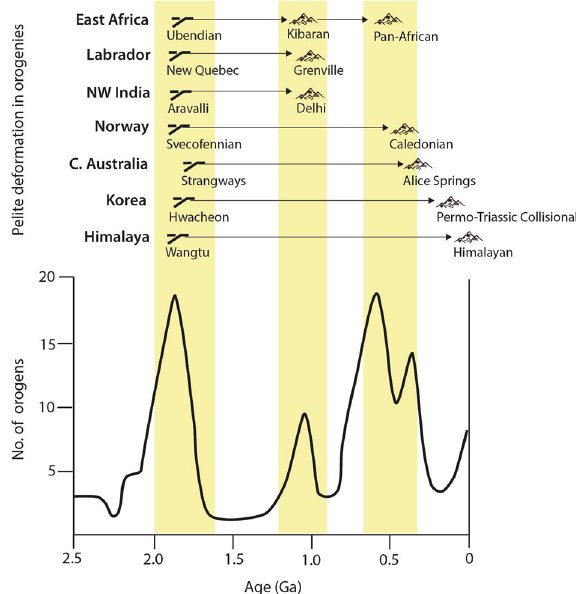
Fig. 8 Reactivation of Palaeoproterozoic pelites during younger orogenies. Pelites deformed during a subduction-related collision in the Palaeoproterozoic were deformed further during a younger continental collision, particularly during episodes of widespread orogenesis 34 (yellow colour). Peaks in orogen distribution are expressed as numbers of orogen lengths per 100-Myr bins 5 . Details of orogenies in Table